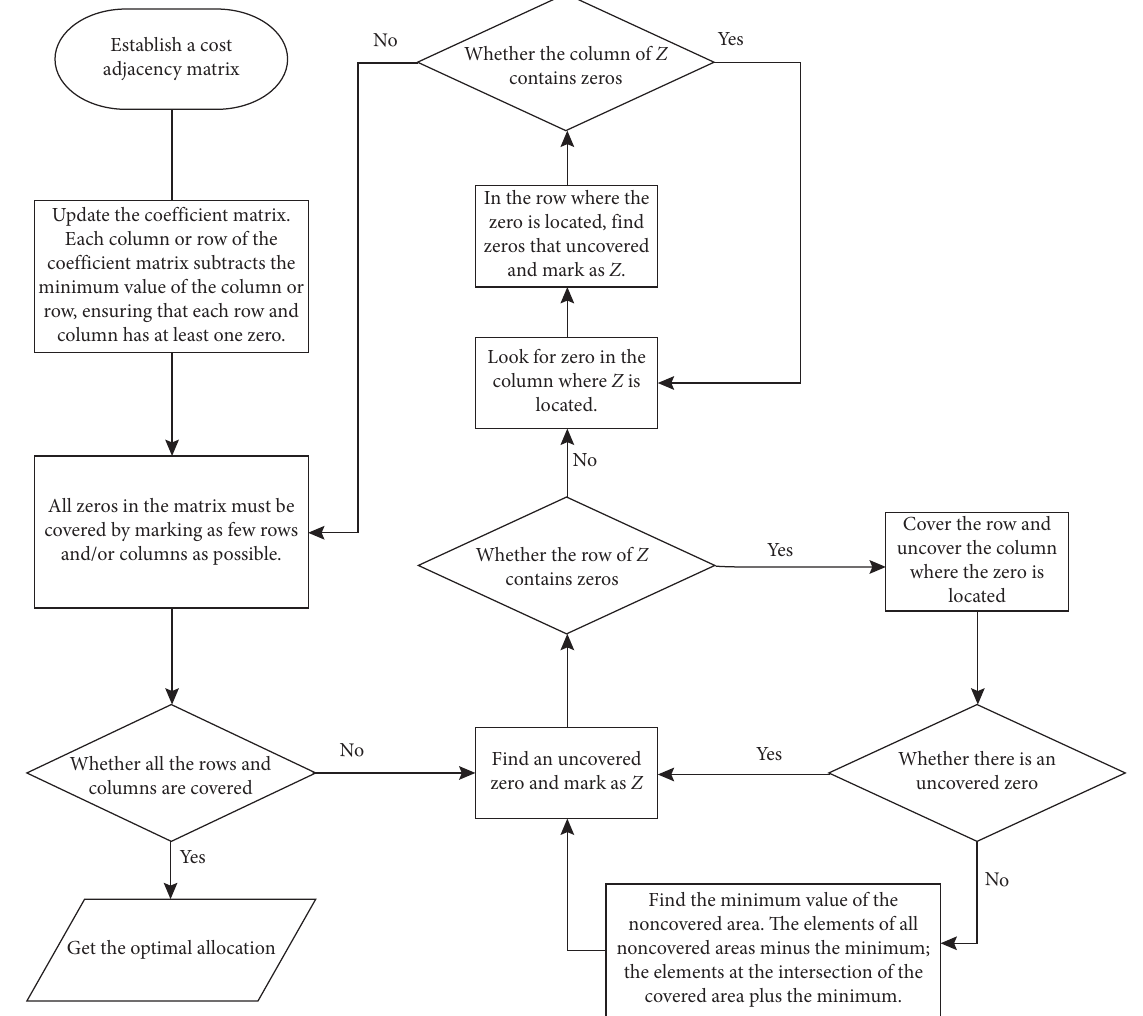
Figure 2: The process of bipartite networks based optimal